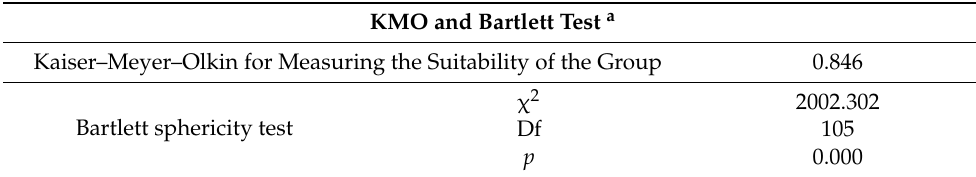
Table 3. Baseline indicators of exploratory factor analysis of the